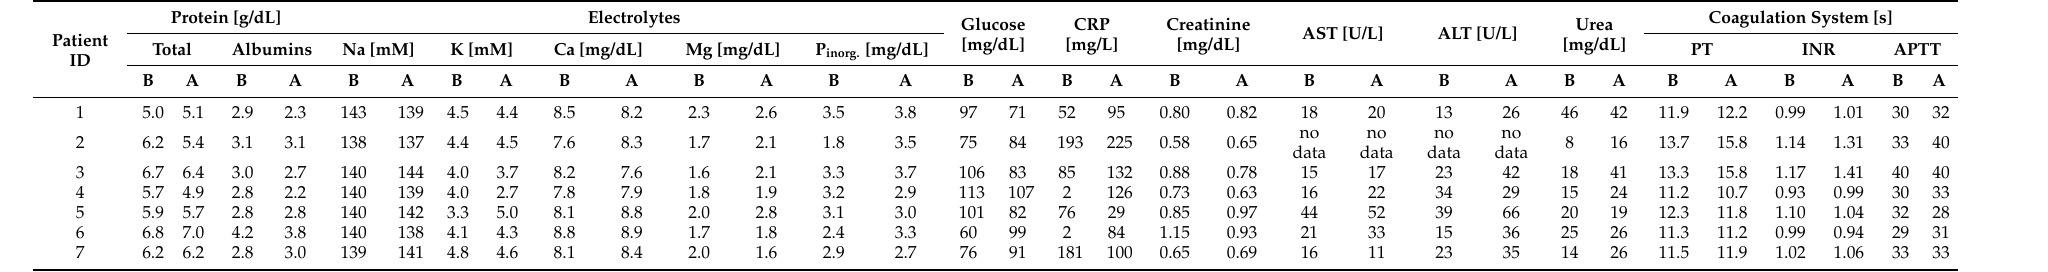
Table 1. Summary of patients’ clinical